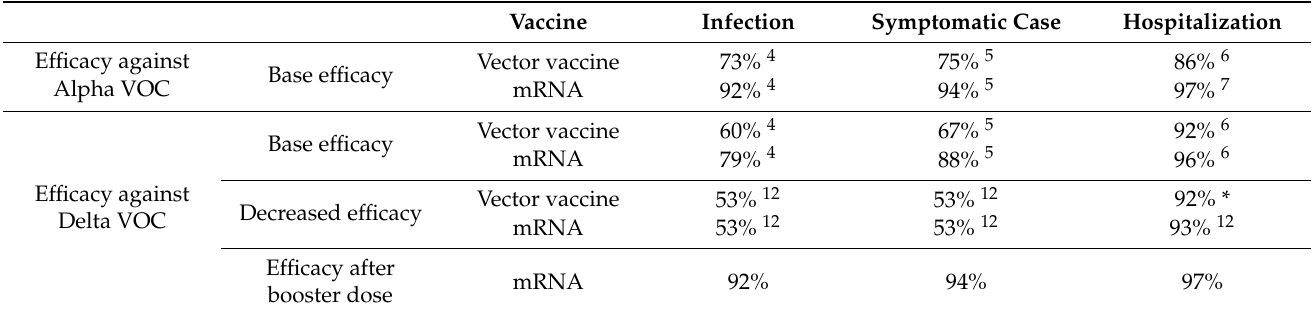
Table 1. Retained efficacies against infection, symptomatic case and hospitalization for mRNA (Comirnaty ® and Spikevax ® ) and vector vaccines (Vaxzevria ® and Janssen COVID-19 vaccine) according to the predominant SARS-CoV-2 variant. Vaccine Infection Symptomatic Case